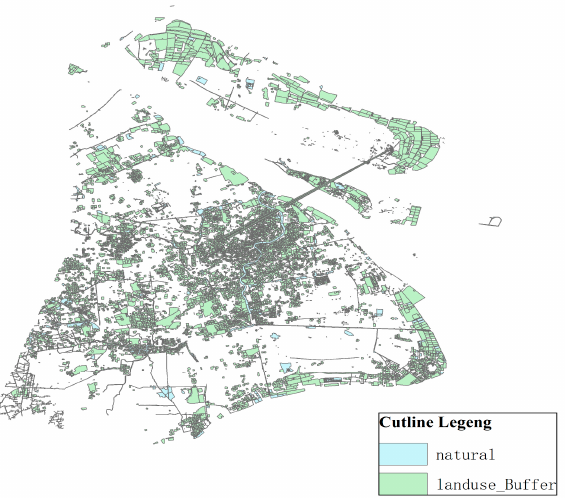
Figure 8. Industrial land buffer zone.